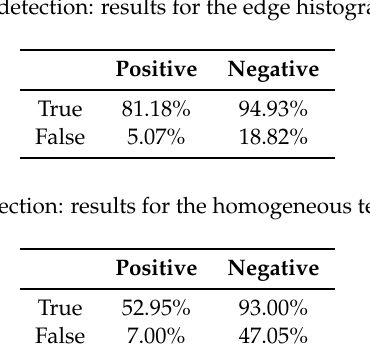
Table 1. Knife detection: results for the edge histogram descriptor.